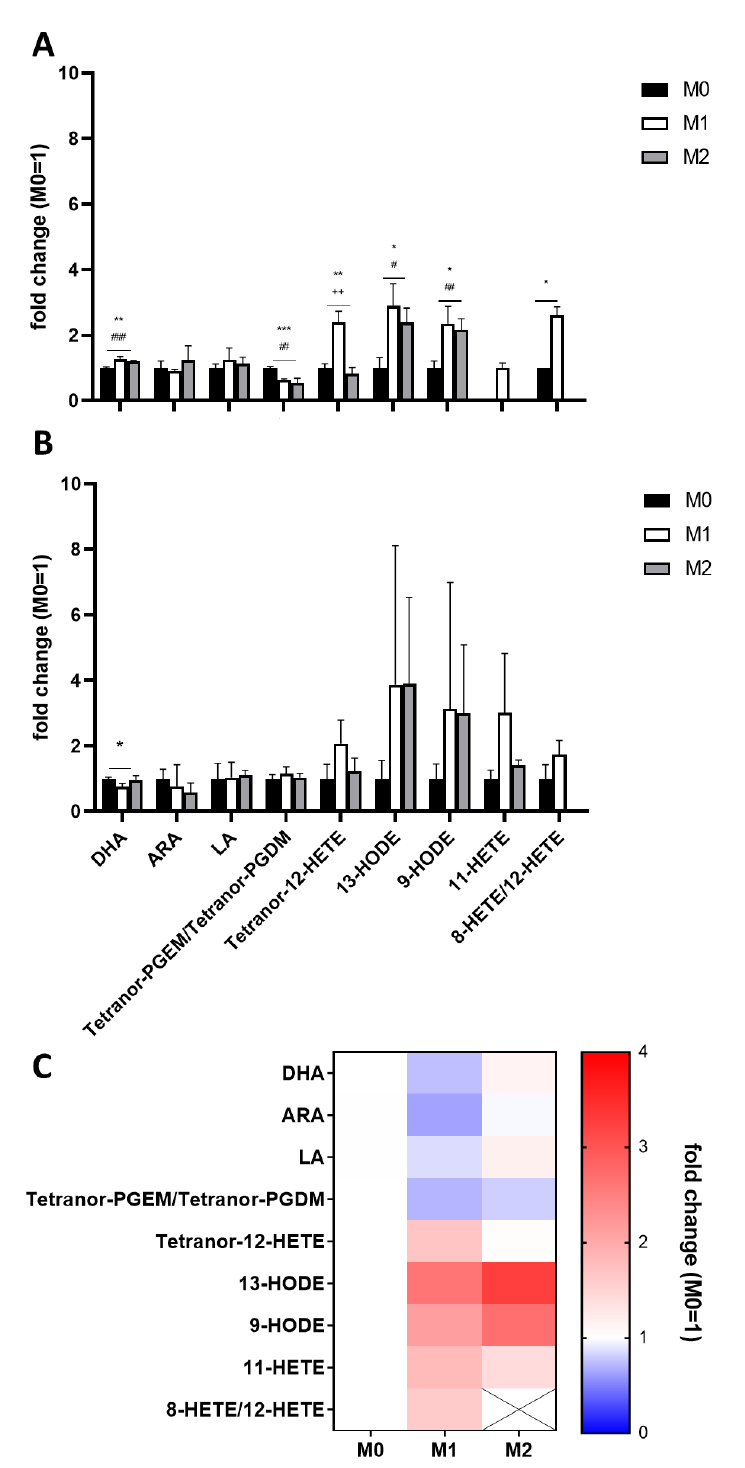
Figure 7. LC-MS/MS analysis of two independent EV isolations ( A , B ) of differently polarized THP-1 macrophages. Measurements were performed as triplicates and results are expressed as fold changes relative to M0. ( C ) Heatmap of the mean fold changes calculated from both EV isolations. Statistics: unpaired Student’s t -test; M0/M1 (*); M0/M2 (#), M1/M2 (+), p ≤ 0.05 (*/#), p ≤ 0.01 (**/##/++), p ≤ 0.001 (***/###). ARA—arachidonic acid; DHA—docosahexaenoic acid; HETE— hydroxyeicosatetraenoic acid; HODE—hydroxyoctadecadienoic acid; LA—linoleic acid; PGDM— prostaglandin D2 metabolite; PGEM—prostaglandin E2